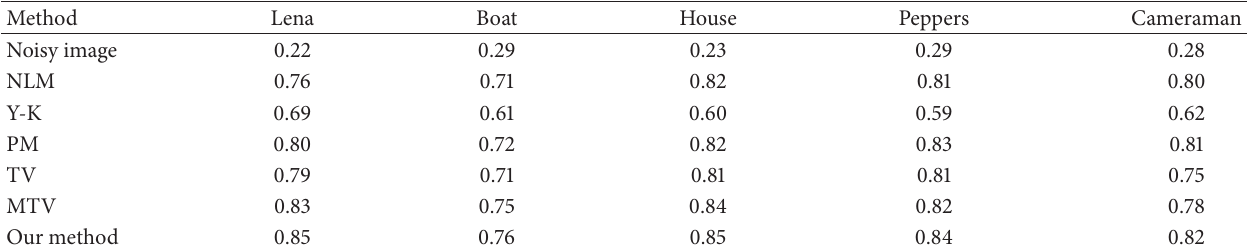
Table 3: SSIM comparison with different methods for noisy image ( 256 × 256 ).